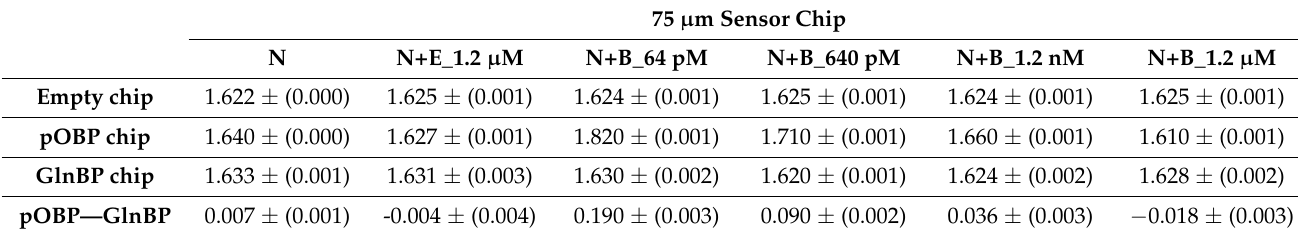
Table 3. Variation of the 75 µ m sensor chip voltage in three different